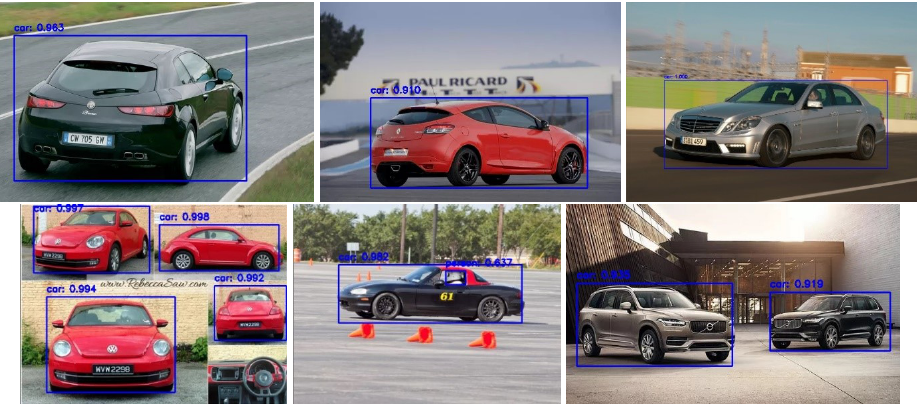
Figure 7. LSUN-Stanford car dataset: Images with appropriate bounding